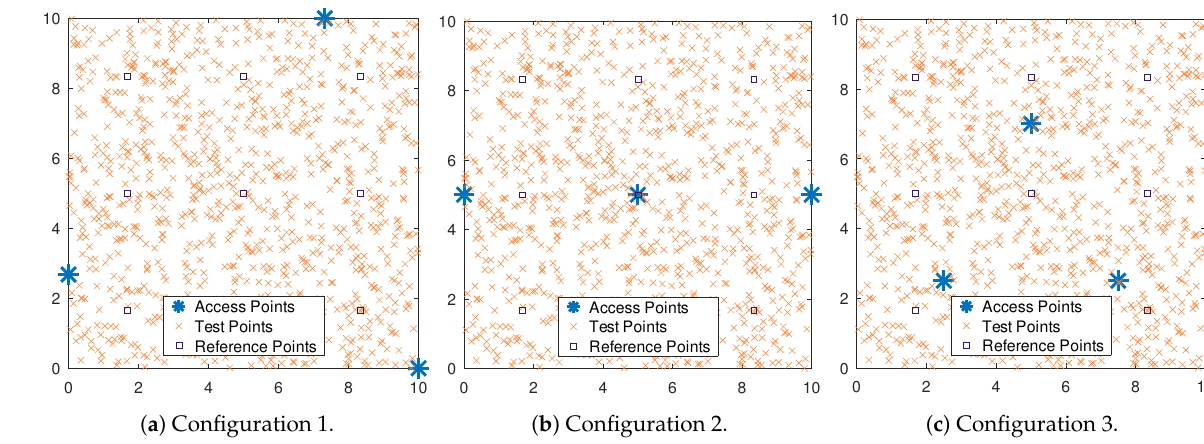
Figure 5. Simulated scenarios with different AP arrangements.